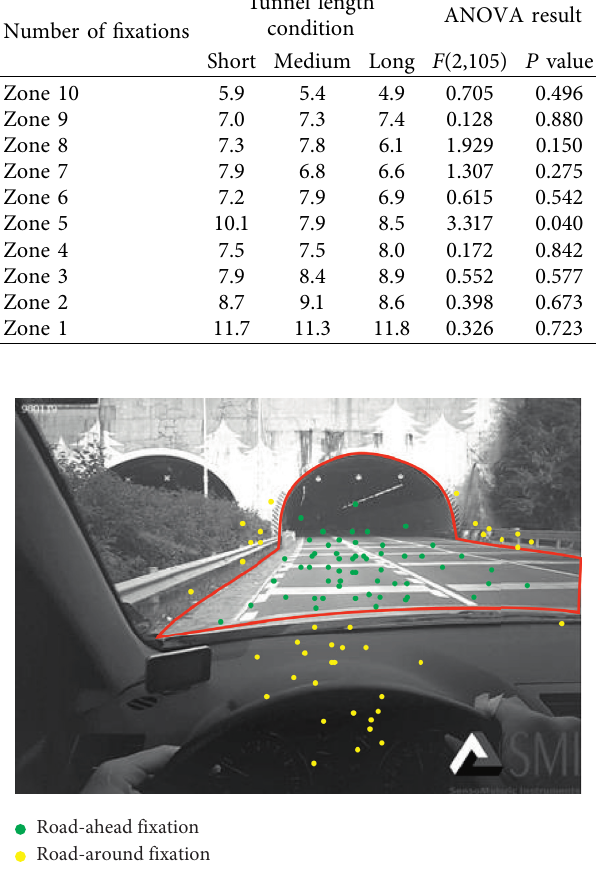
Figure 8: Division of fixation